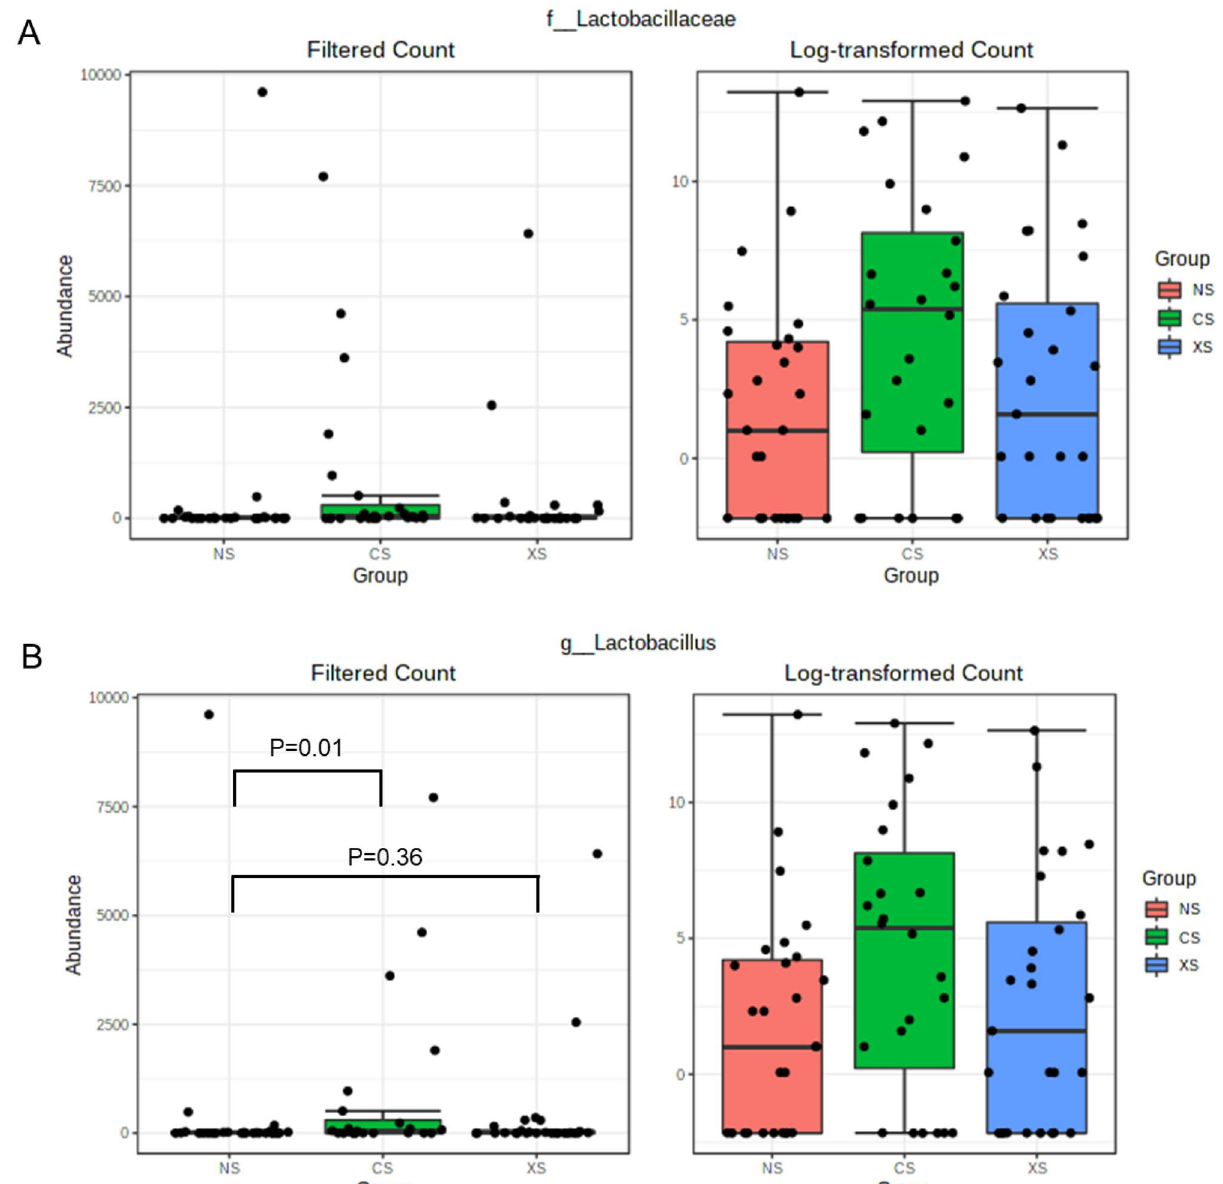
Figure 5. Log-transformed abundances of family Lactobacillaceae ( A ) and genus Lactobacillus ( B ) in the duodenal luminal microbiome of never-smokers (NS) (red), current smokers (CS) (green), and ex-smokers (XS)